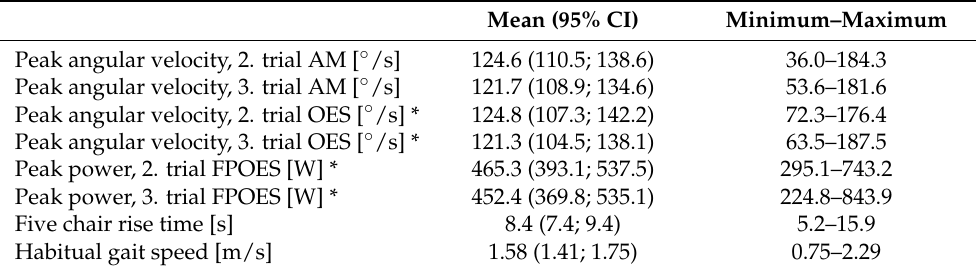
Table 2. Outcome parameters as measured by a thigh-worn activity monitor (peak angular velocity), force plates, and an opto-electronic system (peak angular velocity and peak power) and a stopwatch (chair rise time and gait speed) for all participants ( n = 20).